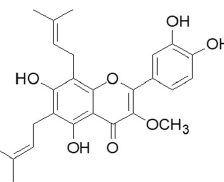
Figure 1. The chemical structure of 5,7,3′,4′-tetrahydroxy-3-methoxy-6,8-diprenylflavone (BF-B).